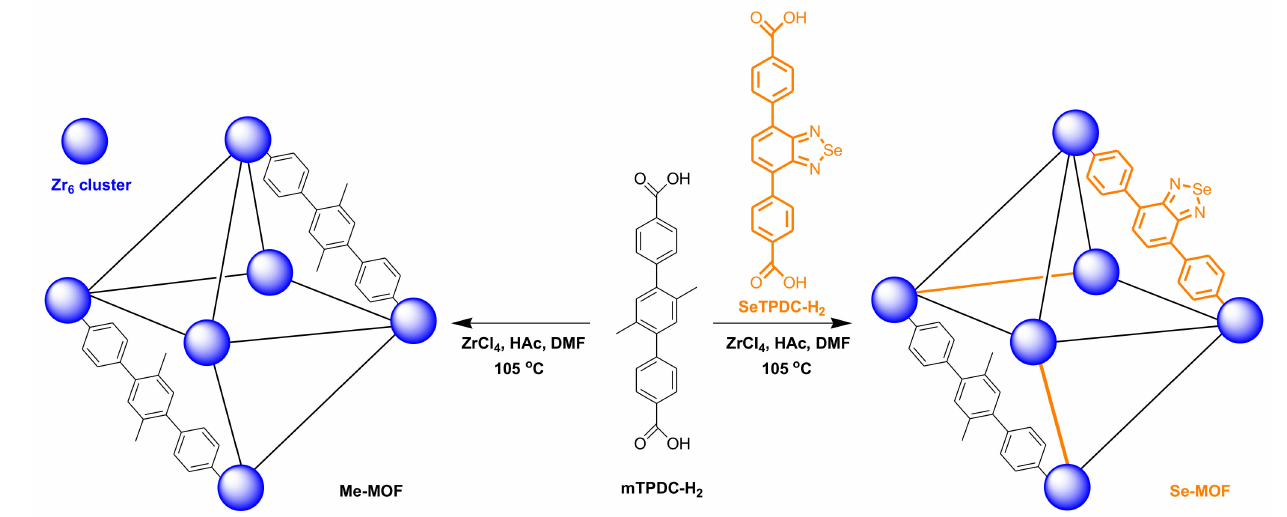
Figure 1. Schematic representation of the preparation for Me-MOF and